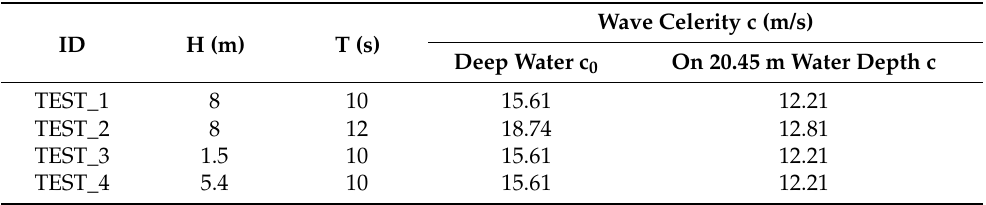
Table 1. Wave characteristics used for wind model implementation.